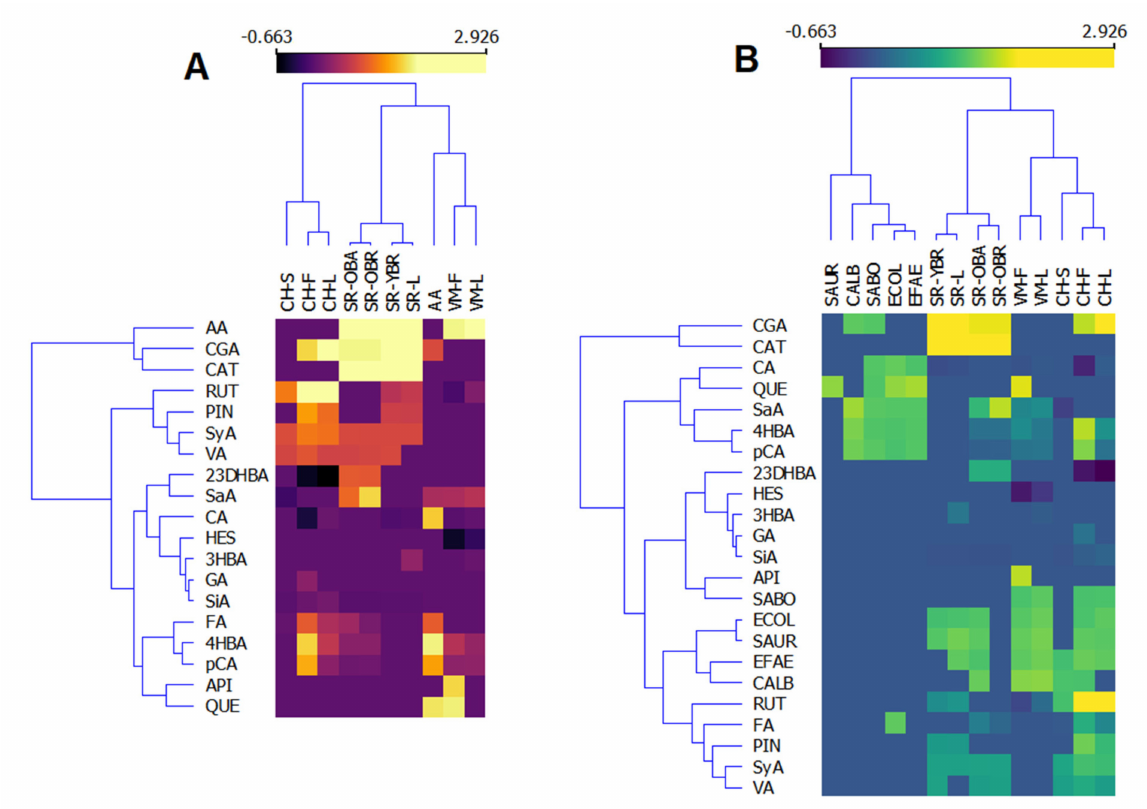
Figure 1. Heatmaps of the phenolic composition and antioxidant ( A ) and antimicrobial ( B ) activities of investigated extracts of Valeriana montana (VM), Salix retusa (SR), and Campanula